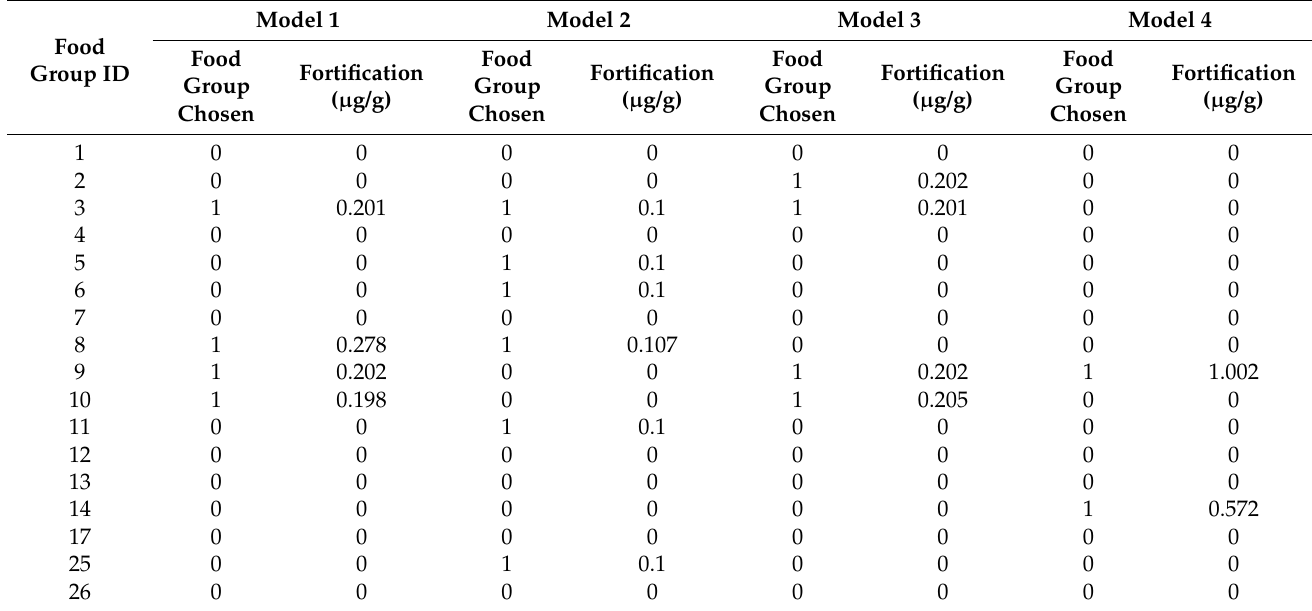
Table 4. Model parameters of the optimization model. The food group chosen is a binary variable (0,1). This variable, if 1, signifies that the food group has been considered in the optimization model, and the corresponding fortification values are reported along with